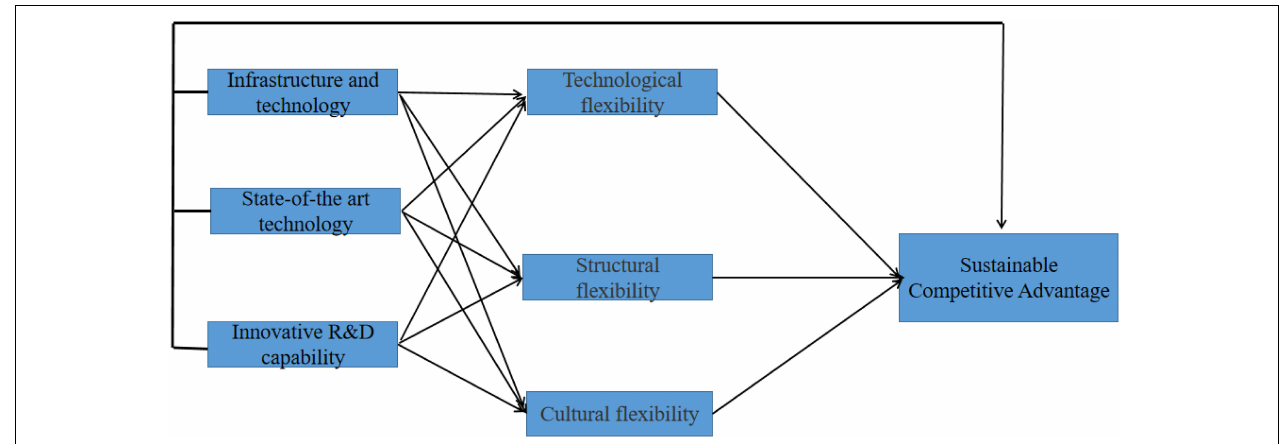
FIGURE 1 | Concept